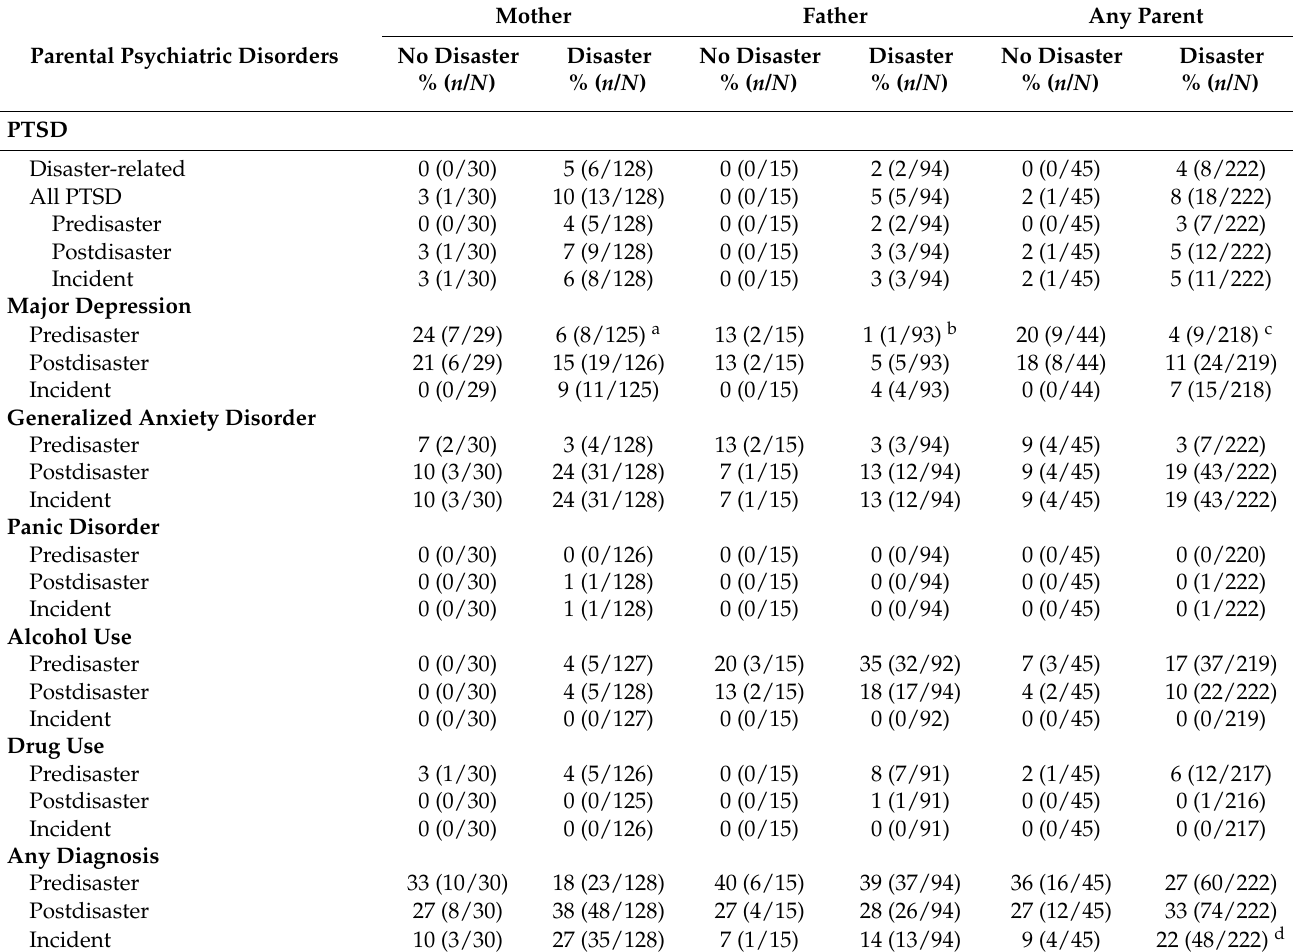
Table 3. Parental psychiatric disorders by disaster exposure.